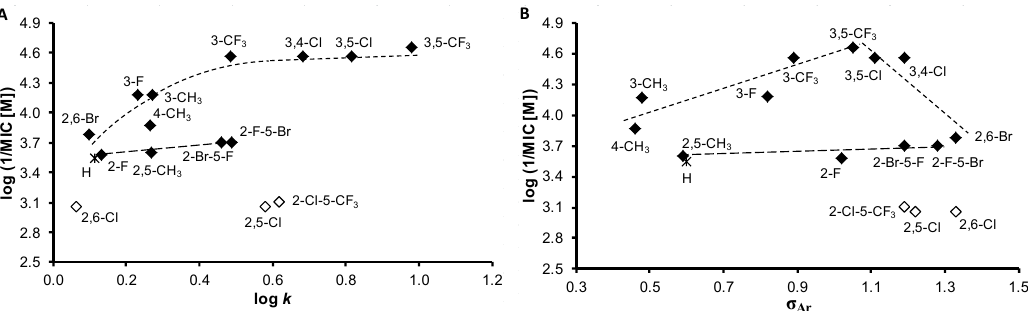
Figure 4. Relationships between in vitro antitubercular activity against M. tuberculosis log (1/MIC (M)) and lipophilicity expressed as log k ( A ) and electronic Hammett’s σ parameters of ring-substituted anilide ring ( B ) of studied compounds. (Derivatives excluded from SAR are illustrated by empty symbols.).